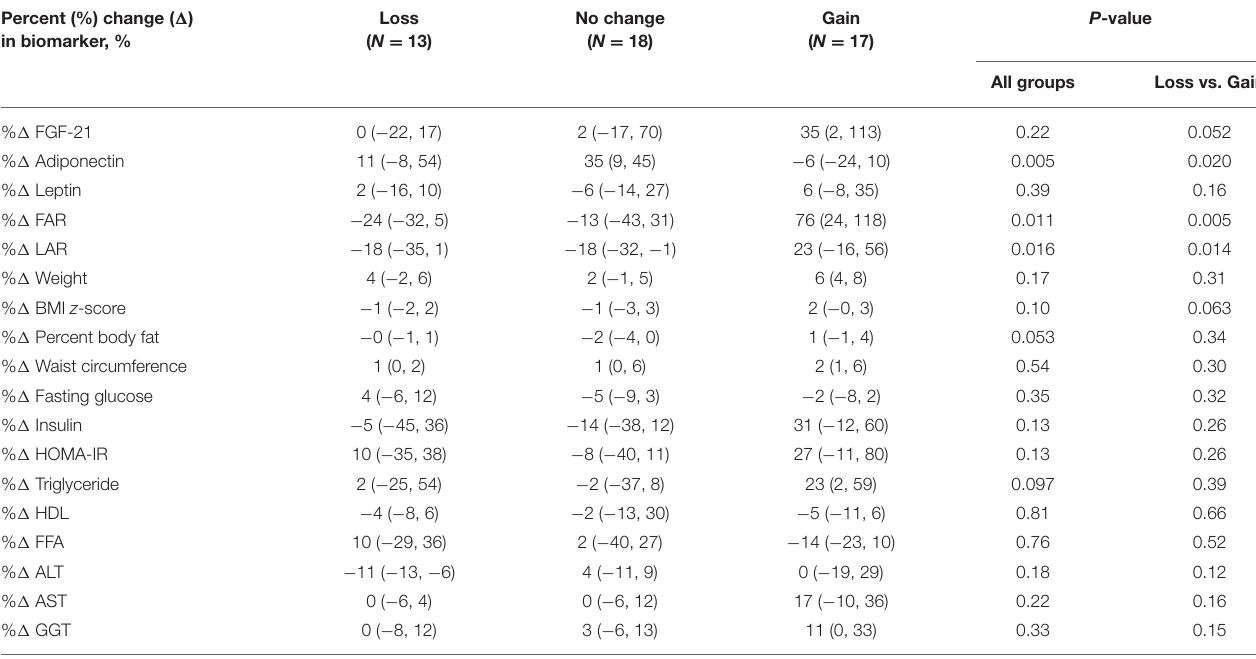
TABLE 3 | Summary and comparison of percent change in biomarkers between loss, no change, and gain groups. Percent (%) change ( 1 ) in biomarker, %